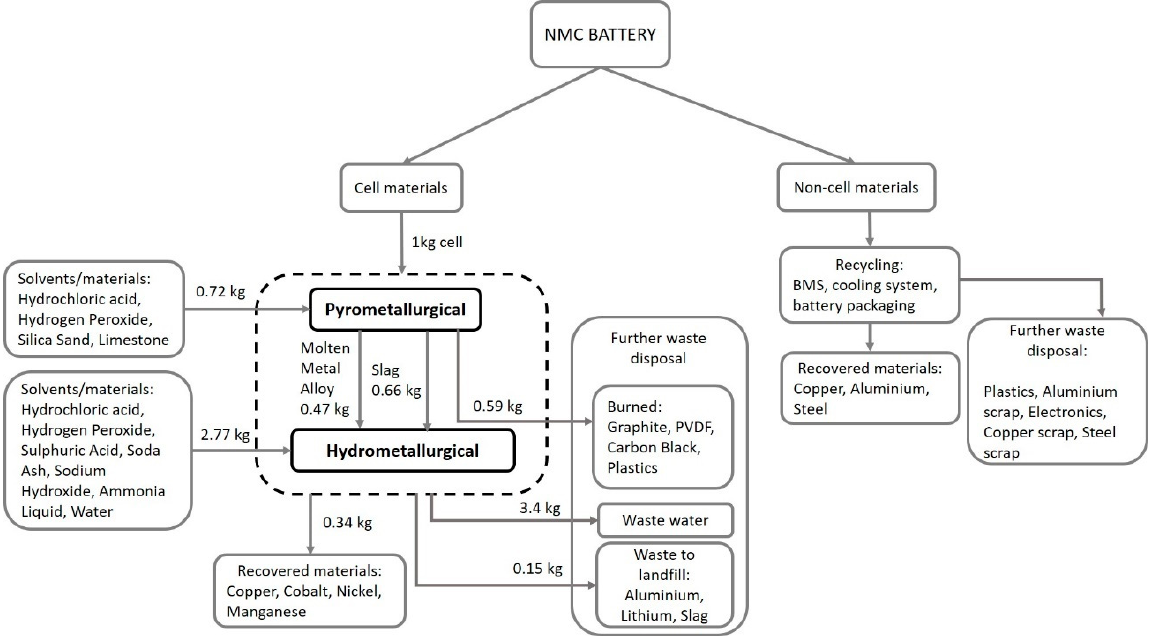
Figure 2. End-of-Life of the battery components.